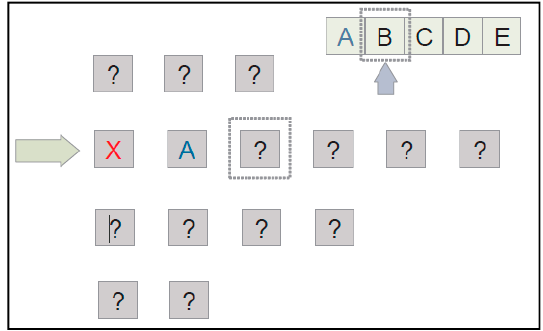
Figure 11. Validation has failed again, so we consider the first shape of the band as noise, and move onto the next one. The expected character to be validated is still “A”.